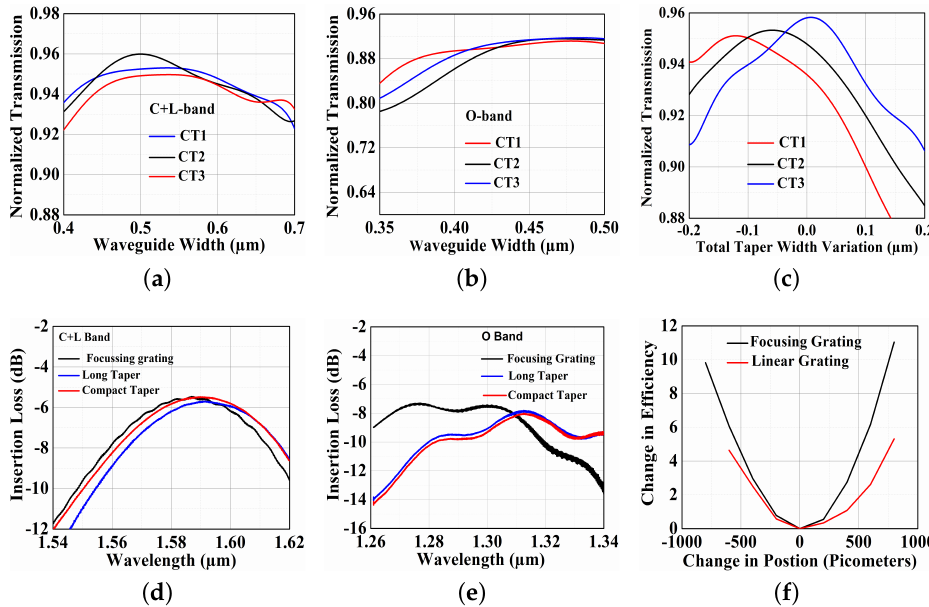
Figure 13. Variation in Transmission Efficiency of Compact Taper with the Width of the Waveguide for the ( a ) C + L (1.53–1.63 µ m) band and ( b ) O-band (1.26–1.36 µ m), ( c ) Variation in transmission efficiency for different b values. Experimental coupling efficiency of the adiabatic (long), focusing grating and compact taper configurations of GC on SOI Platform for ( d ) C + L and ( e ) O band, ( f ) Alignment tolerance of the focusing and linear grating